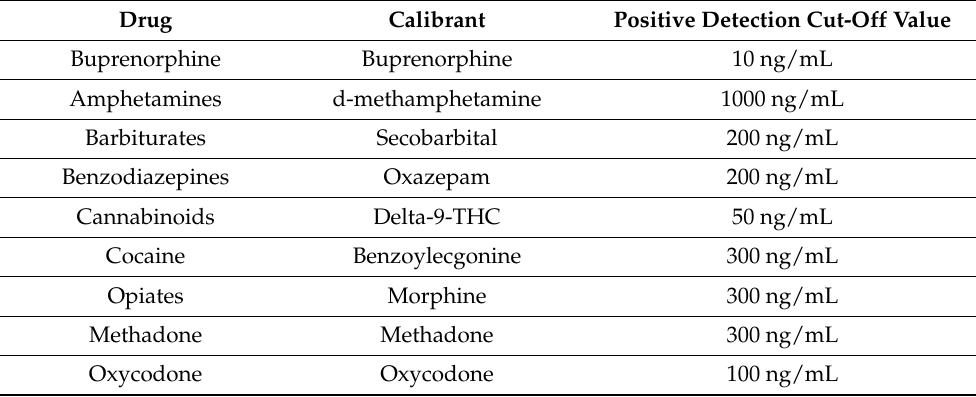
Table 5. Drugs measured by chemiluminescence and their calibrants and positive cut-off